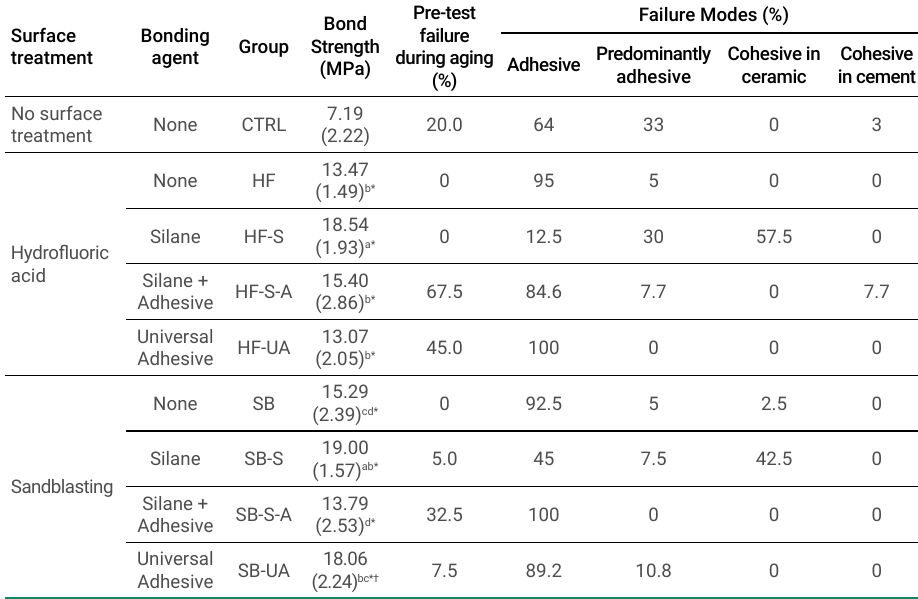
Table 4. Means (standard deviations) of bond strength data (MPa), percentage of pre-tested failures during thermo-cycling, and failure modes of each tested group. Surface